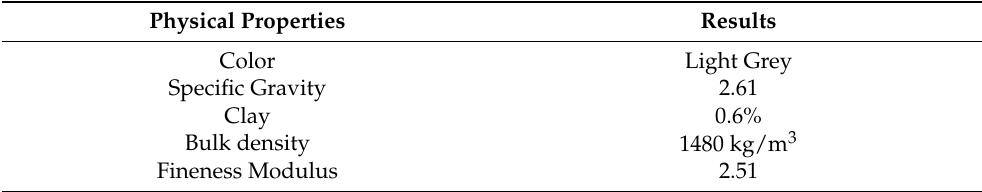
Table 1. Physical Properties of Silica